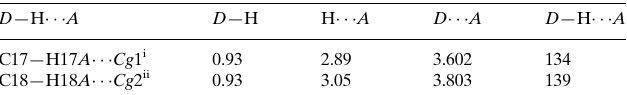
Hydrogen-bond geometry (A˚ , (cid:4)